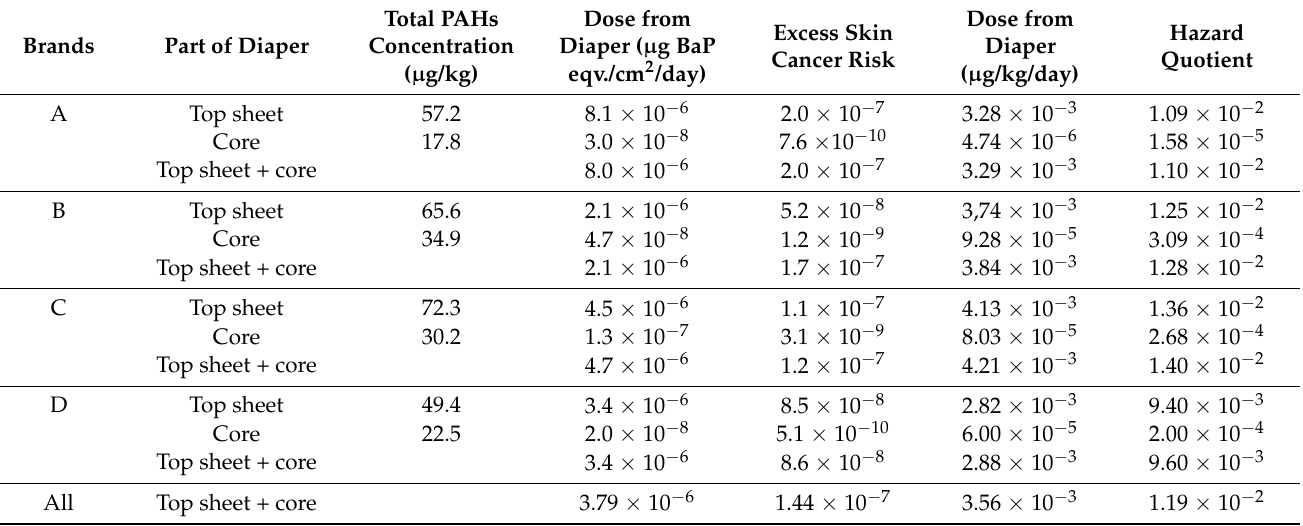
Table 6. Excess skin cancer and neurobehavioral risks of polycyclic aromatic hydrocarbons (PAHs) in the core and the top sheet of four brands of diaper, separately or combined.